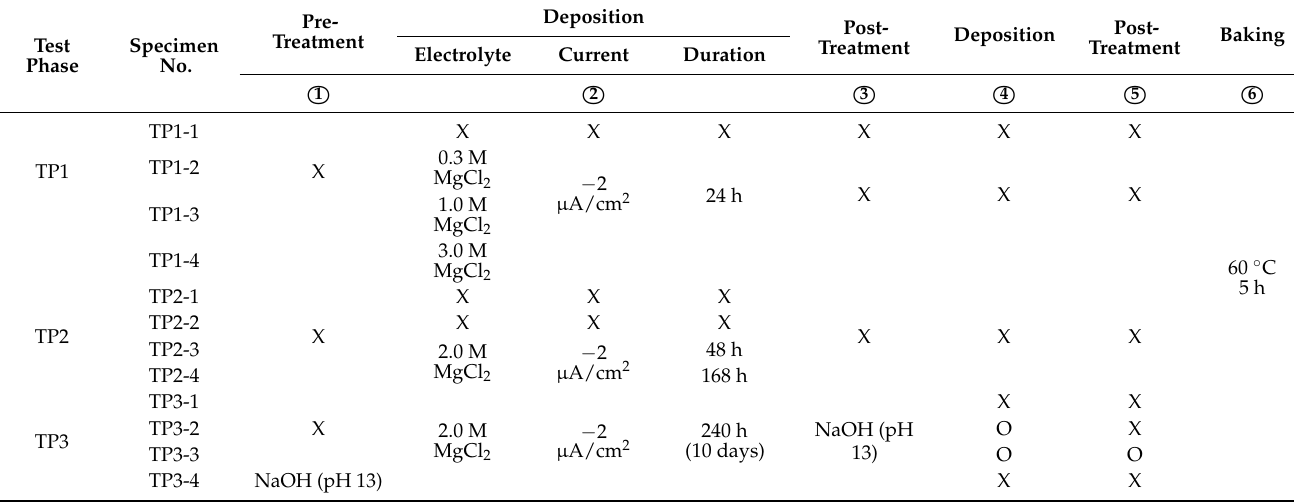
Table 2. Summary of electrochemical deposition treatment (EDT) processes used in test phases 1, 2 and 3.